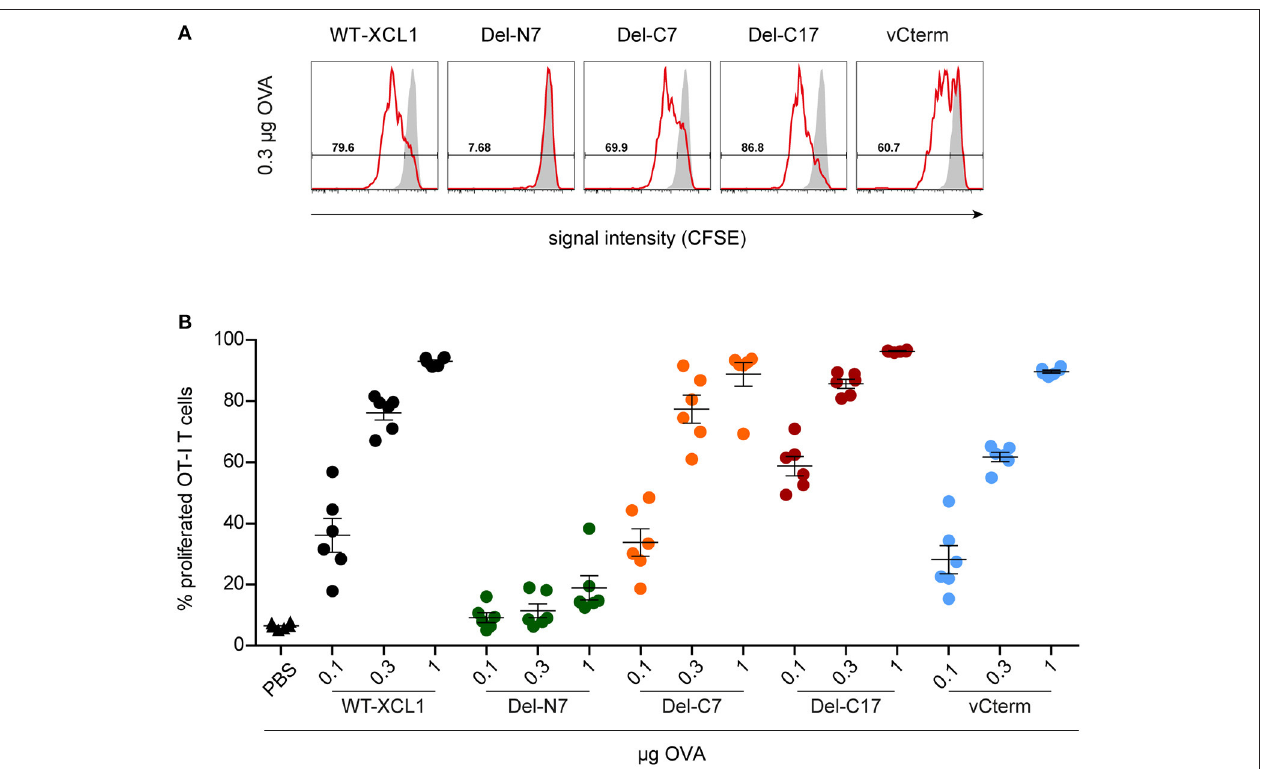
FIGURE 5 | Induction of CD8 + T cell proliferation after in vivo targeting of antigen using XCL1-OVA and its variants Del-N7, Del-C7, Del-C17, and vCterm. Fluorescently labeled OT-I T cells (1 × 10 6 ) were adoptively transferred into syngeneic C57BL/6 mice. One day later the animals were immunized with the indicated amounts (based on the content of OVA) of wt XCL1-OVA and its structural variants (w/o adjuvant). Two days after immunization, the spleens were removed and the percentage of proliferated OT–I T cells was determined using the CSFE dilution assay in flow cytometry. (A) Exemplary histograms of the fluorescence signal obtained with 0.3 µ g of each protein reagent. (B) Percentage of proliferated OT-I T cells after immunization with 0.1, 0.3, and 1 µ g of each protein reagent. Combined data from 2 independent experiments are shown (mean ± SEM).